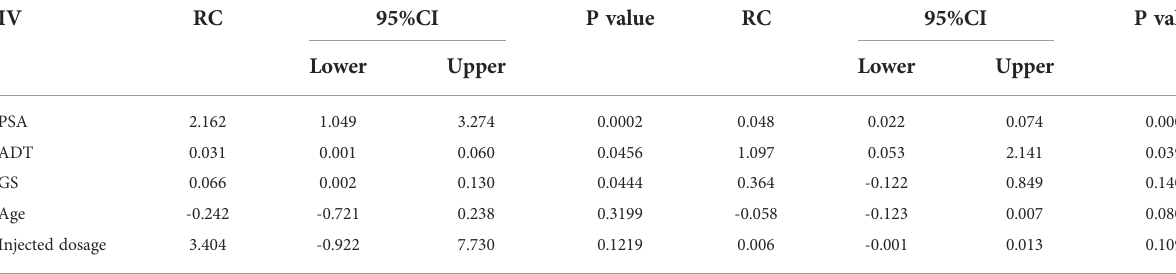
TABLE 3 Univariate and multivariable linear regression analyses: In fl uence of Clinical characteristics on SUVmax.